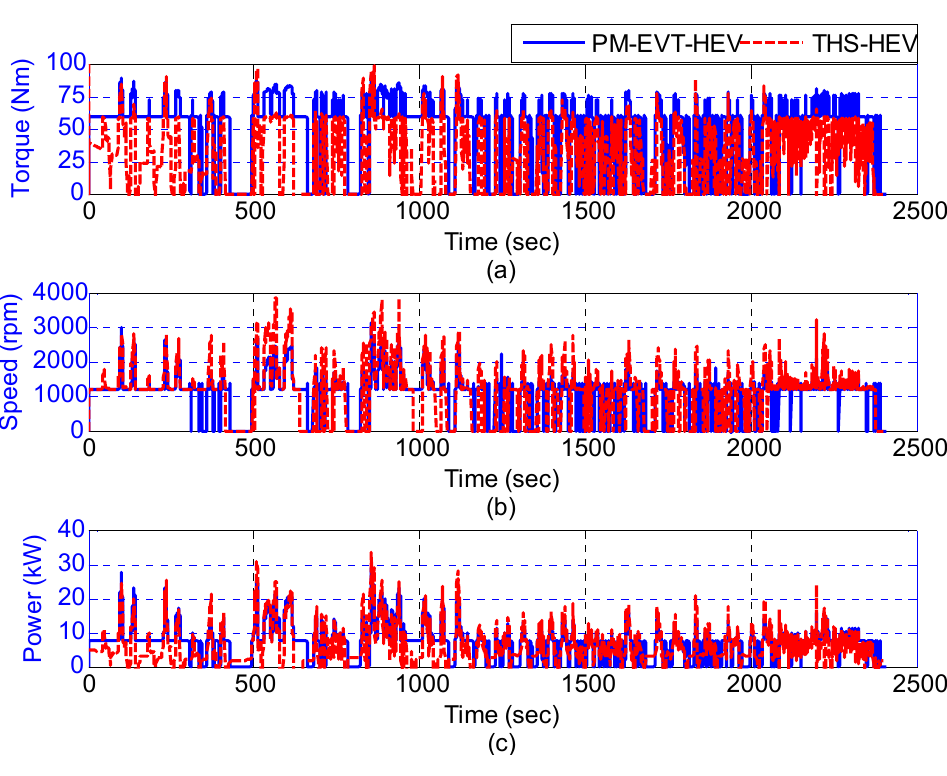
Figure 16. ICE Performance of the PM-EVT-HEV and Prius THS-HEV: ( a ) Torque; ( b ) Speed; ( c ) Power.